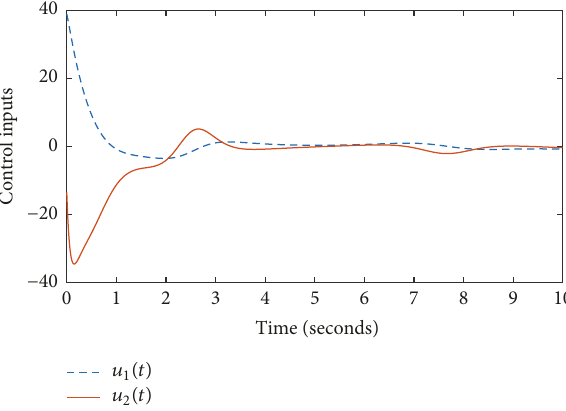
̂𝜁 (𝑡) . Figure 5: Time response of control inputs 𝑢 1 (𝑡) and 𝑢 2 (𝑡) 2